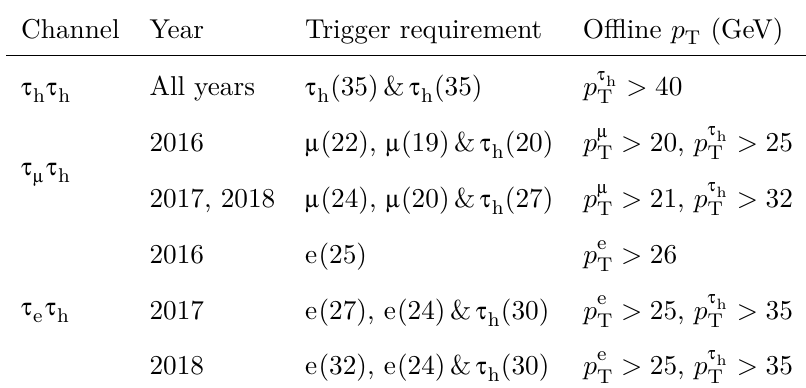
, t t h , and t h t h channels. e t h m thresholds indicated for T